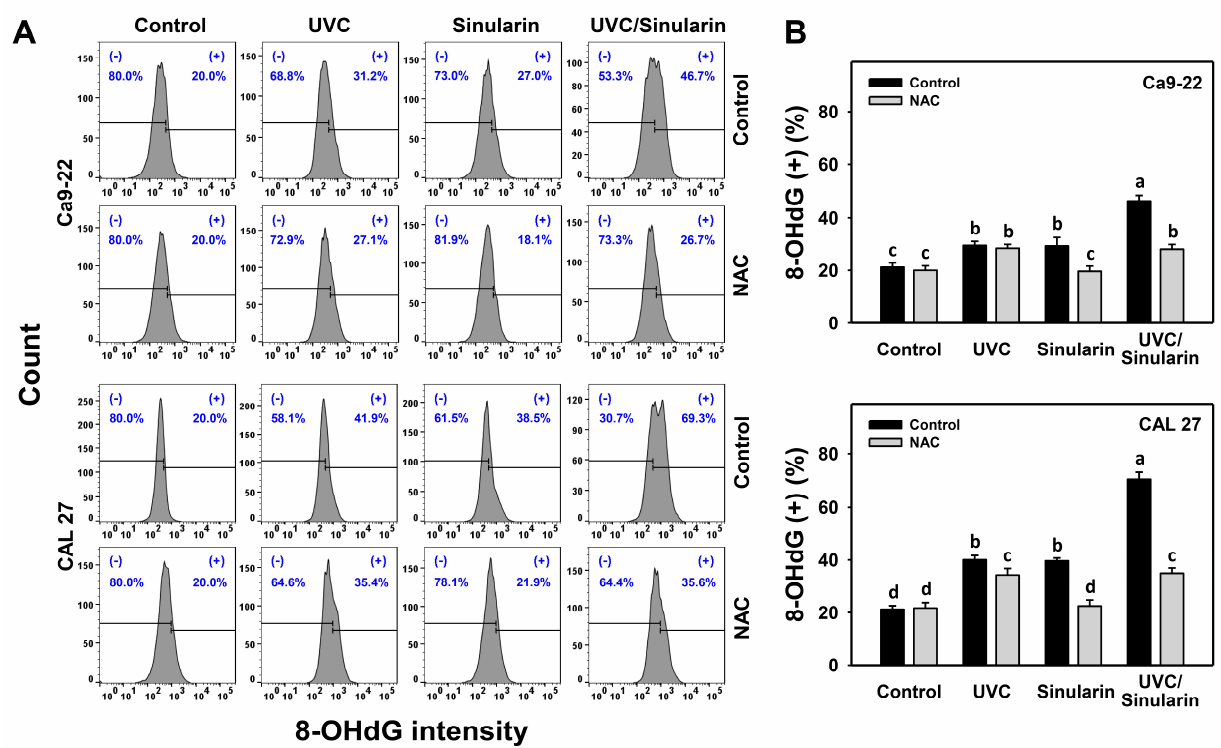
Figure 10. 8-OHdG expressions of the UVC and/or sinularin treatments. Following the NAC preincubation (5 mM for 1 h) or not, the cells were arranged into four kinds of treatments: the control (0.1% DMSO in medium), UVC, sinularin, and UVC/sinularin for 48 h. The UVC and/or sinularin conditions were 12 J/m 2 , 2 μM and 10 J/m 2 , 3 μM for oral cancer cells (Ca9-22, CAL 27) for 48 h, respectively. ( A , B ) 8-OHdG patterns and quantifications analysis. (+) indicates 8-OHdG-positive (%). For the multi-comparisons, the treatments marked without repeated characters (a to d) differ significantly ( p < 0.0001). The data were plotted as the mean ± SD ( n = 3).